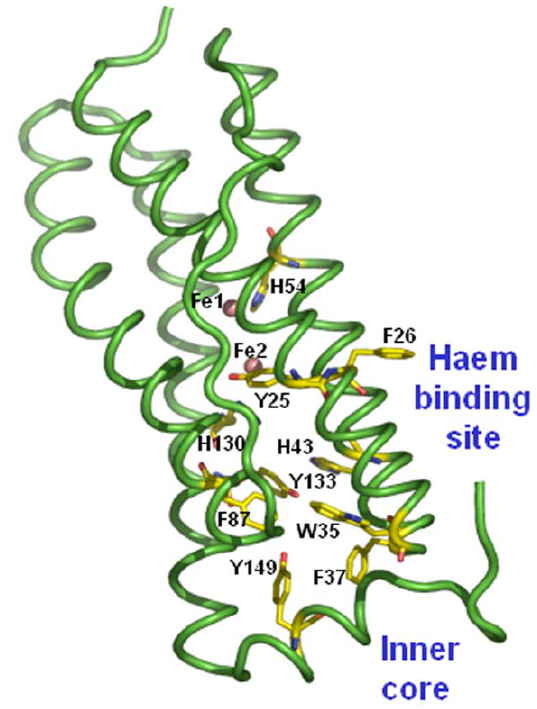
Figure 8. Predicted electron funnel between inner core and ferroxidase centre/haem binding site in Mtb SeMet-BfrA. Residues involved in forming the possible electron transfer path are shown as sticks (in atom type color). The metal ions of the di-iron centre are shown as brown spheres.